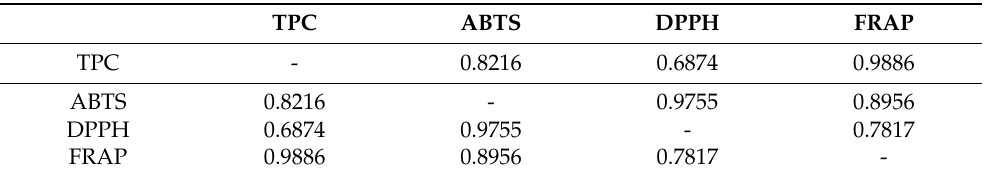
Table 5. Correlation analysis (coefficient of determination, R 2 ) among spectrophotometric parameters (TPC, DPPH, ABTS, and